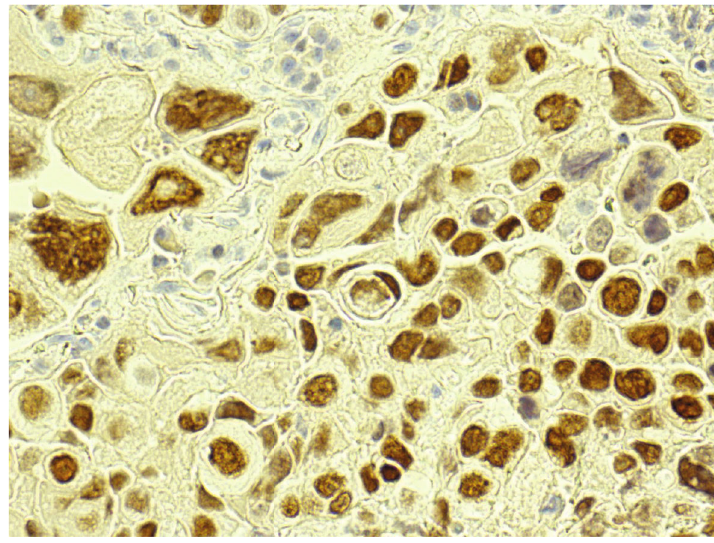
Figure 2: Tumor cells are strongly immunoreactive for GATA3.